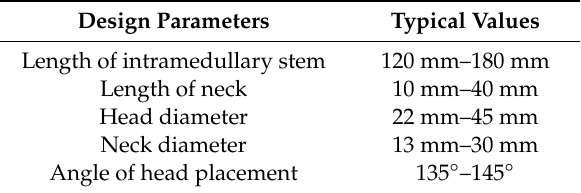
Table 1. Typical ranges for hip implant’s design parameters.